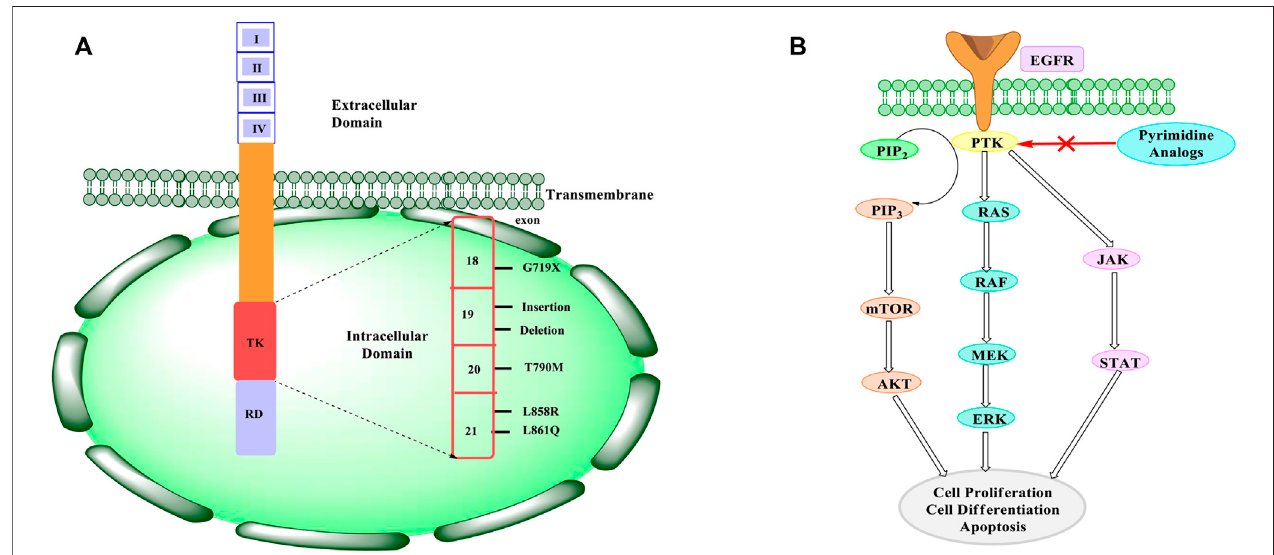
FIGURE 1 | (A) EGFR structure and mutations. EGFR consists of three domains namely an extracellular domain, a transmembrane domain, and an intracellular domain.Theextracellulardomainconsistsoffoursubunitsthatareresponsibleforbindingtotheligandandresultingindimerization.Thisresultsindownstreamsignaling. The intracellular domain consists oftyrosinekinase (TK)and aregulatorydomain(RD), which areresponsible forregulatingthesignaling andphysiological processofthe EGFR. The TK domain consists of an exon (18 – 21) that shows mutation. The mutations mainly occur at T790M and L858R. (B) Mechanism of inhibiting EGFR. When an EGF ligand binds to the PTK site, it results in the activation of the downstream signalling. Two different pathways are possible. It can activate PI3K pathway or the RAS pathway. PI3K results in the conversion of PIP2 to PIP3, which is further followed by the activation of mTOR and AKT, whereas RAS activation results in the activation ofRAF and MEK. Also, there can be activation of JAK-STAT pathway. Whichever pathway it follows, there ’ s an increase in the cell proliferation, differentiation, andapoptosisofthecell.Incancer,thesedownstreamsignalingareenhancedandhencethereisuncontrolledcellgrowth.Therefore,pyrimidineanaloguesarefoundto inhibit the PTK site where the EGF ligand binds and results in decreasing the downstream signaling. This reduction in downstream signaling helps in reducing the cell proliferation and differentiation of cancerous